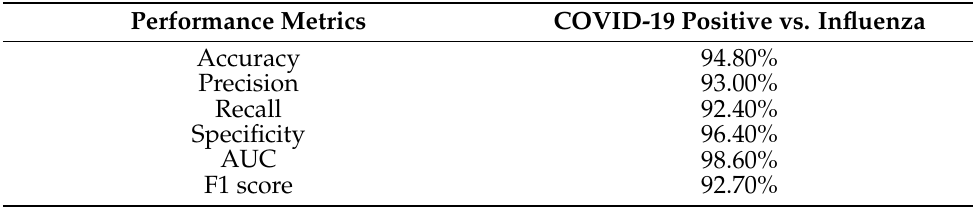
Table 3. Performance metrics of XGBoost model for predicting the given record as COVID-19-positive or